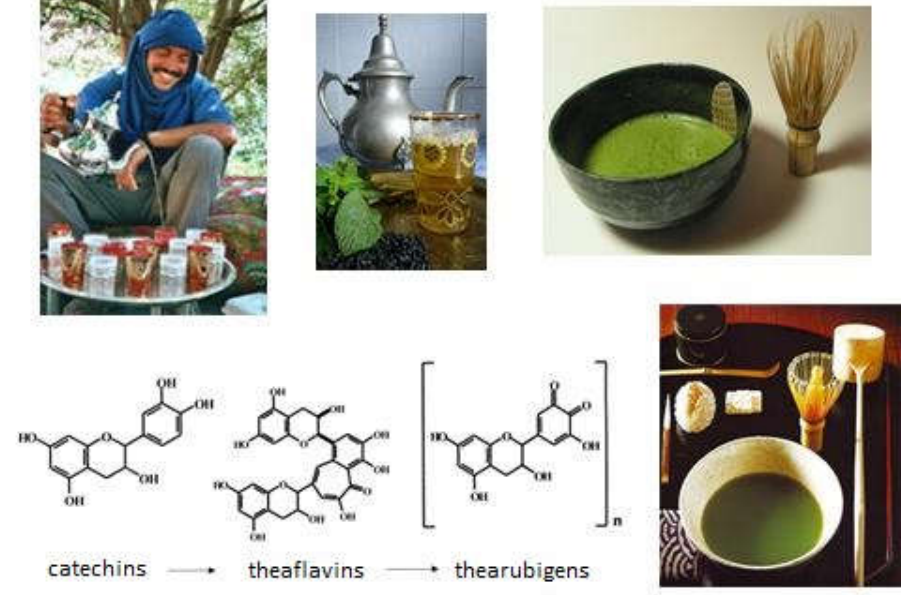
Figure 4. Polymerization of catechins.